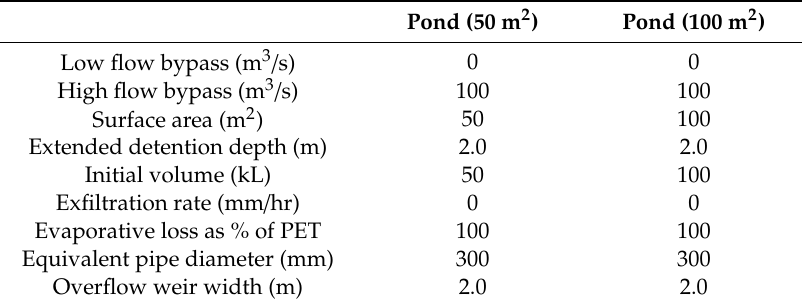
Table A2. Parameters of two types of ponds in MUSIC.